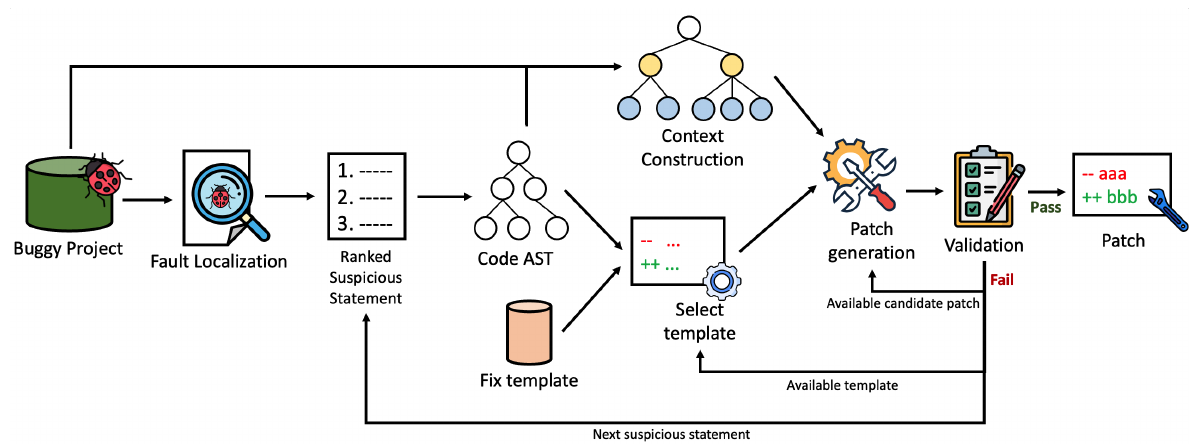
Figure 2. Overall process of